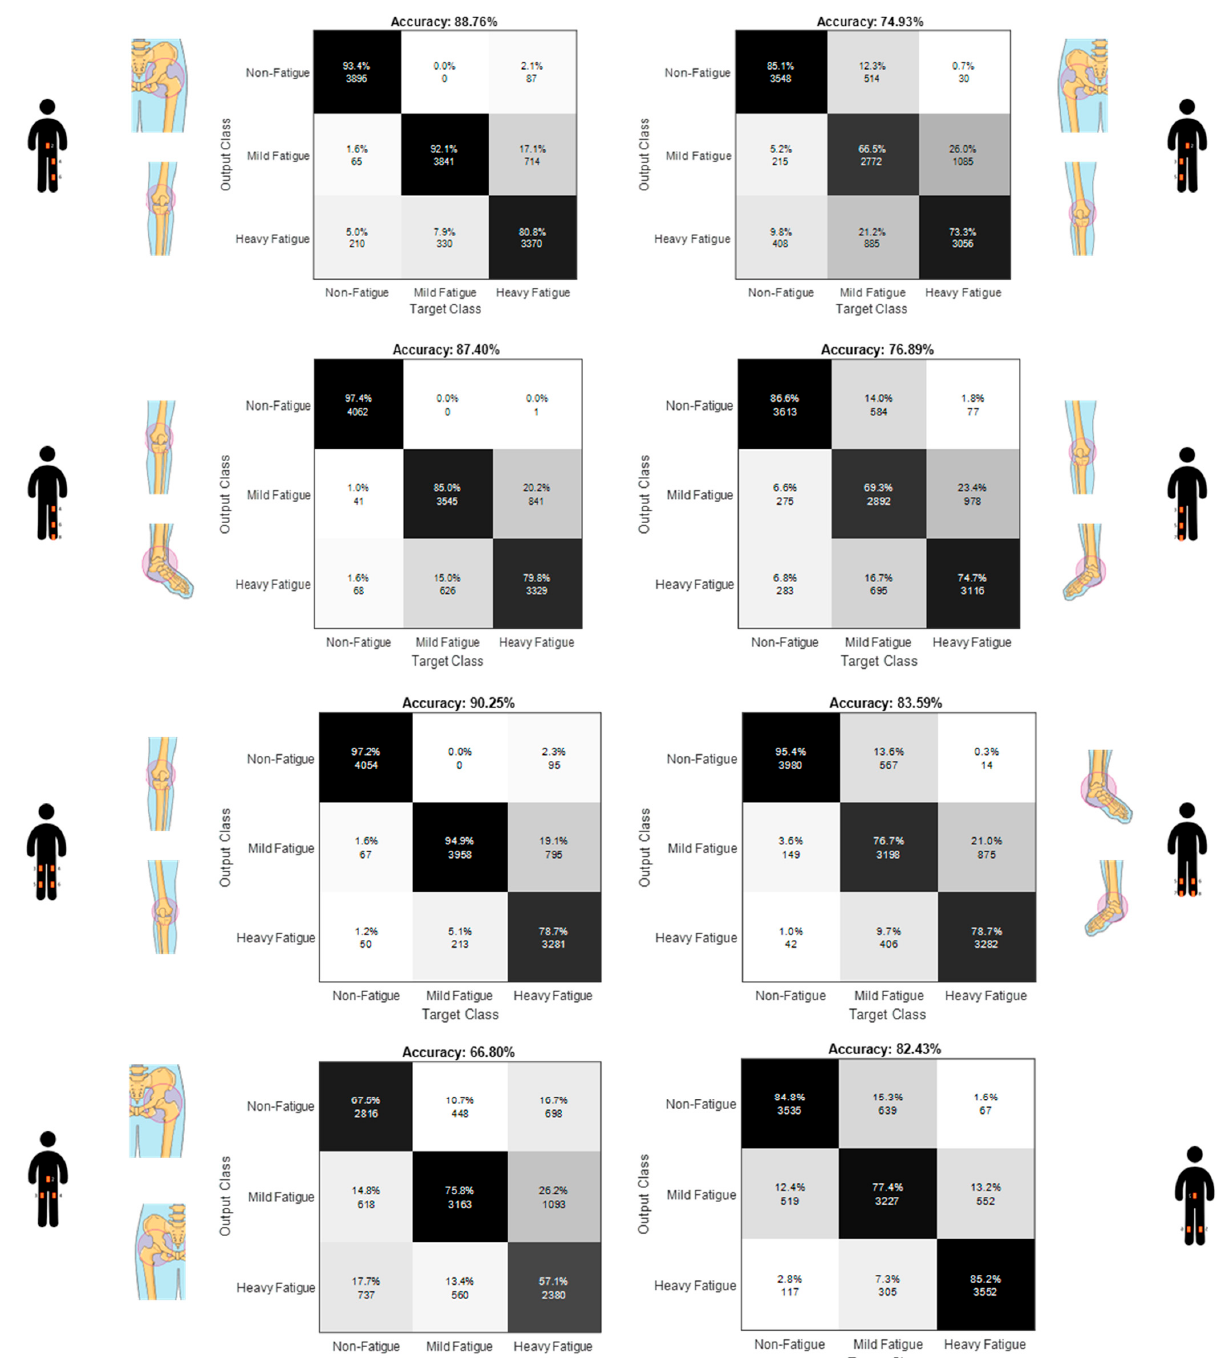
Figure A3. Aggregate confusion matrices with all subjects, 3+ IMUs configurations, up to two joints. Joints present in each configurations are shown.